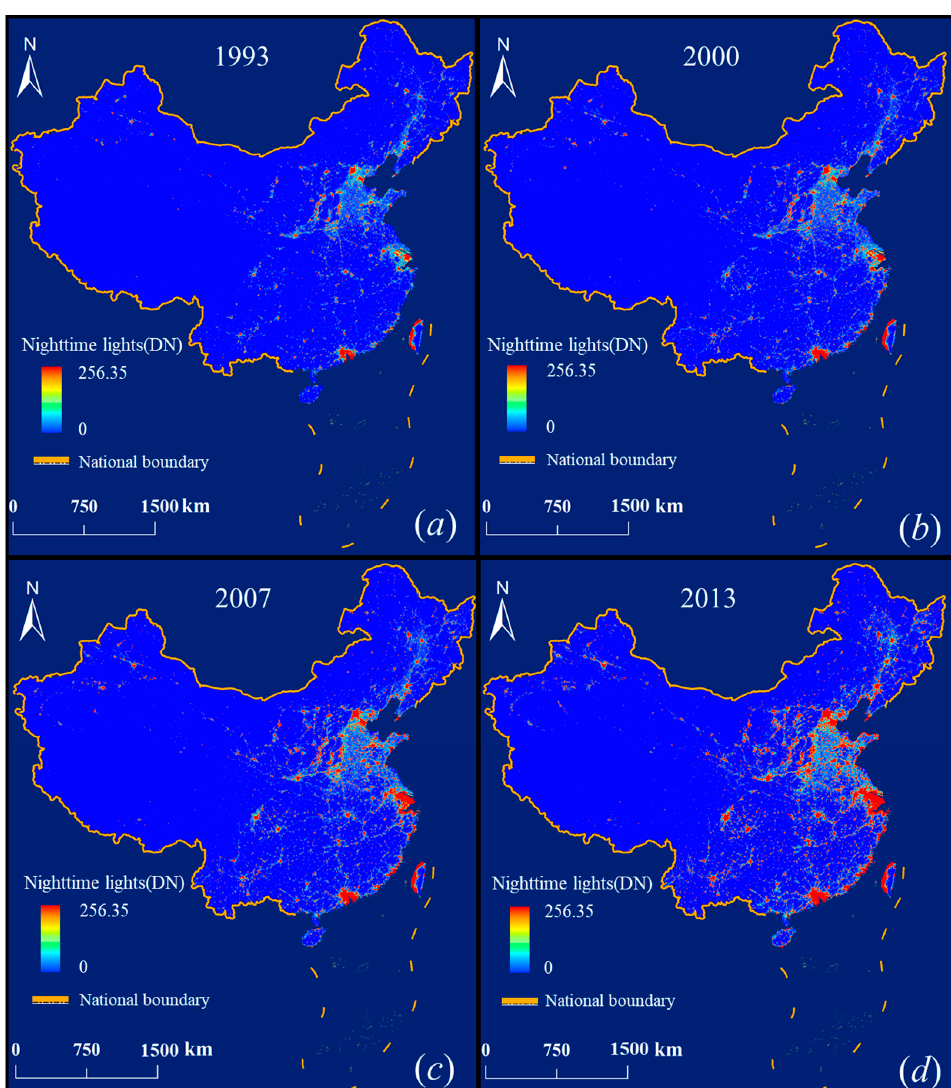
Figure 4. Spatial distribution of the NSL data in China. 1993 ( a ), 2000 ( b ), 2007 ( c ), and 2013 ( d ). Note: according data availability, the 2015 NSL data were replaced by 2013 NSL data.